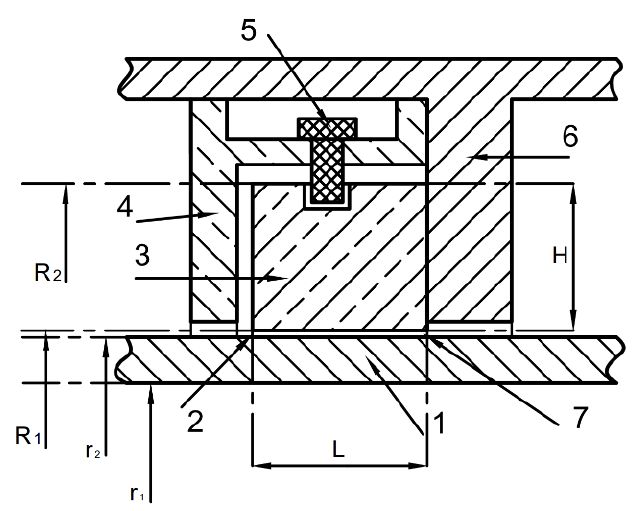
Figure 1. Structural schematic diagram for a cylinder gas film seal between shafts: 1—Inner rotor, 2—Inlet pressure, 3—Sealing ring, 4—Sealing seat, 5—Anti-rotating pin, 6—Outer rotor, 7—Outlet